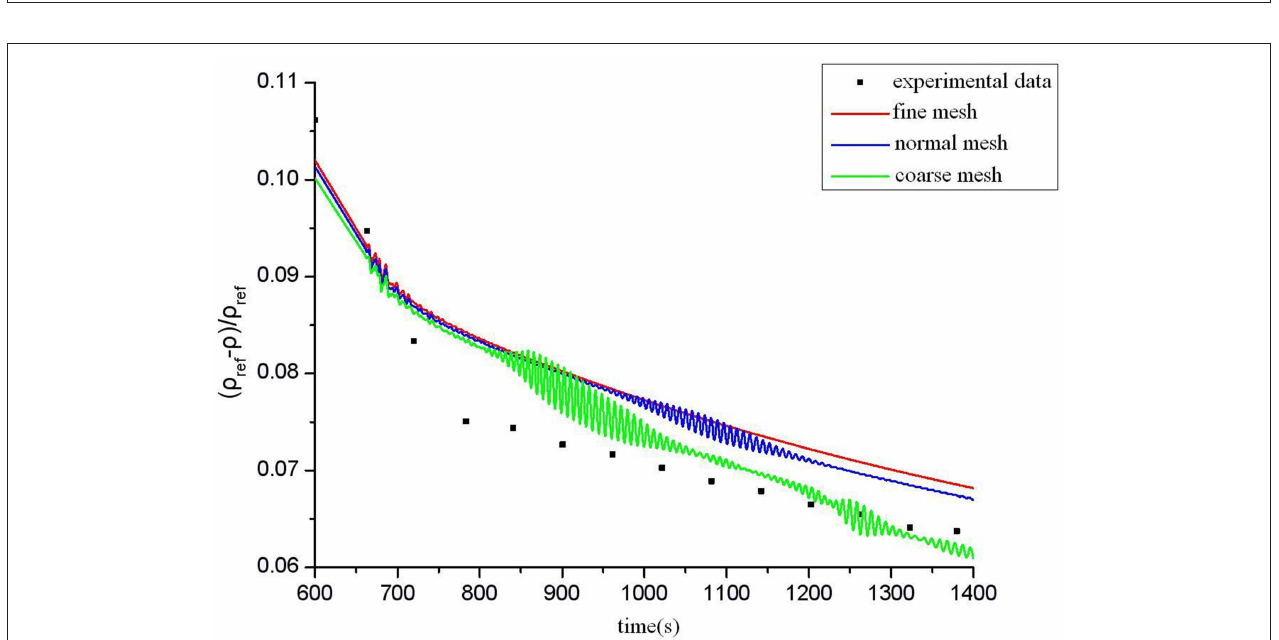
FIGURE 3 | Density comparison(without air inlet).